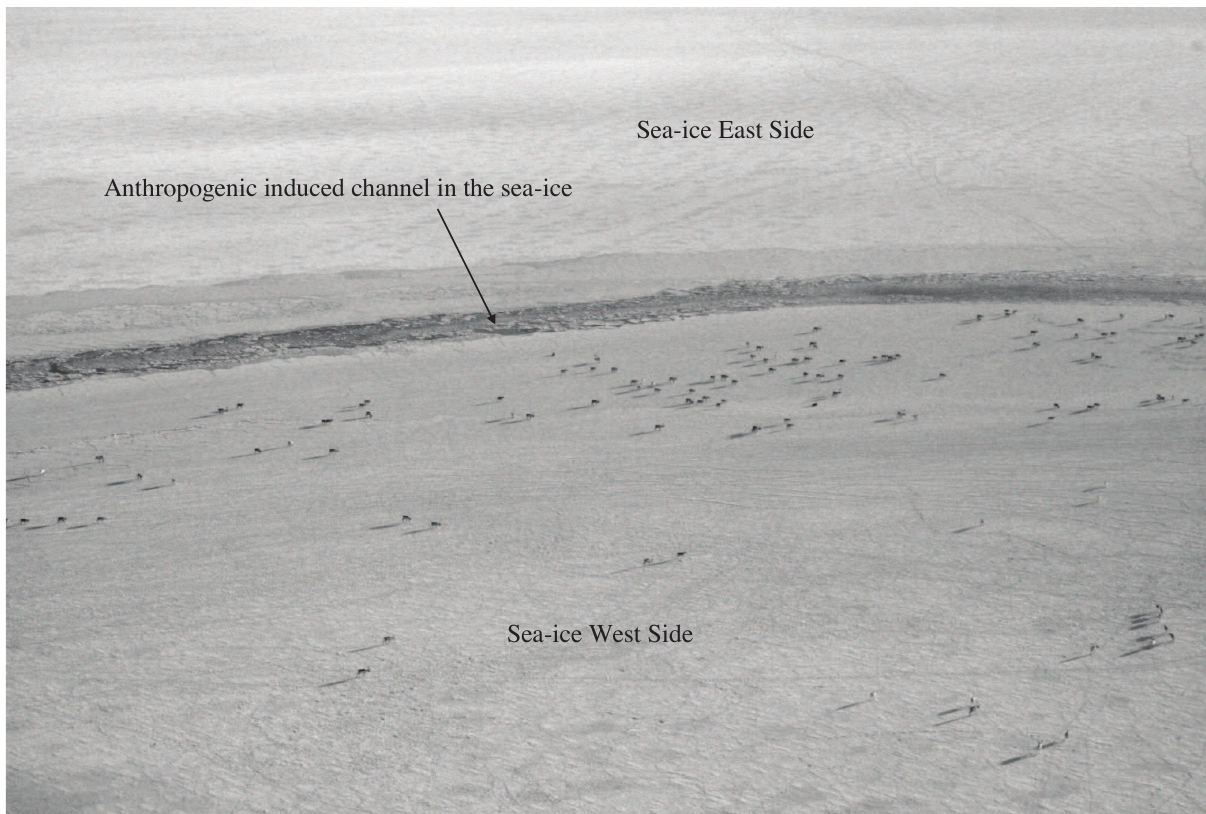
Figure 1. Dolphin and Union caribou aggregated on the west edge of an anthropogenic ice breaking channel near Cambridge Bay, NU, on October 26,